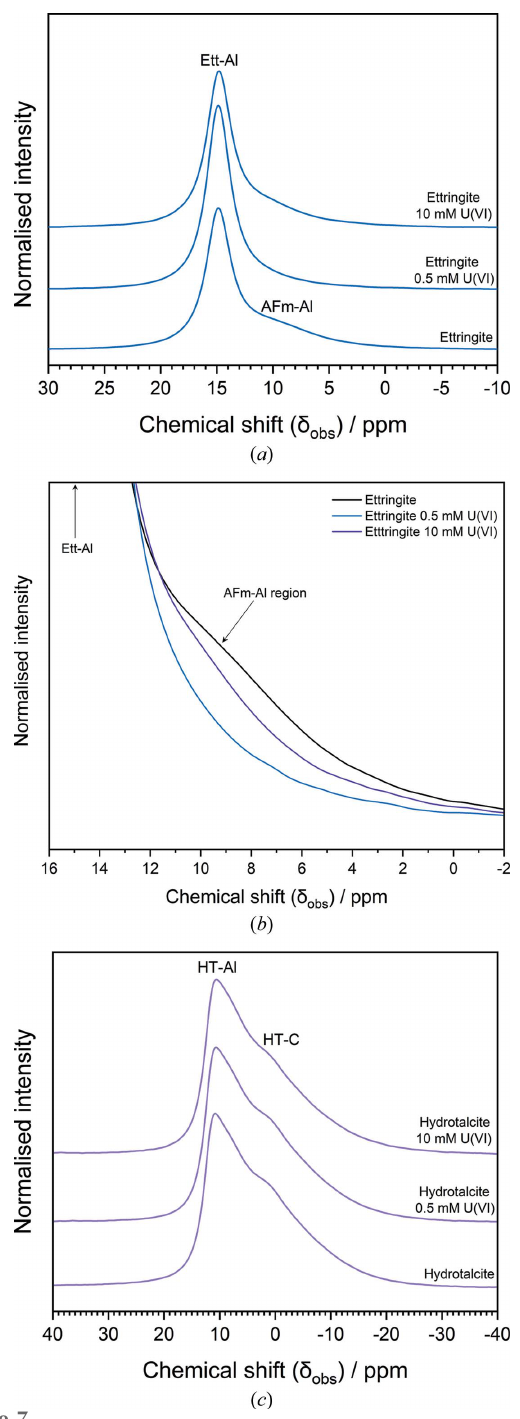
Figure 7 27 Al MAS-NMR ( B 0 = 11.7 T, (cid:6) R = 12.5 kHz) spectra of ( a ) pristine ettringite and ettringite contacted with 0.5 m M and 10 m M U VI ; ( b ) the same data as ( a ) but highlighting the ‘AFm-Al’ region of the spectra; and ( c ) pristine hydrotalcite and hydrotalcite contacted with 0.5 m M and 10 m M U VI